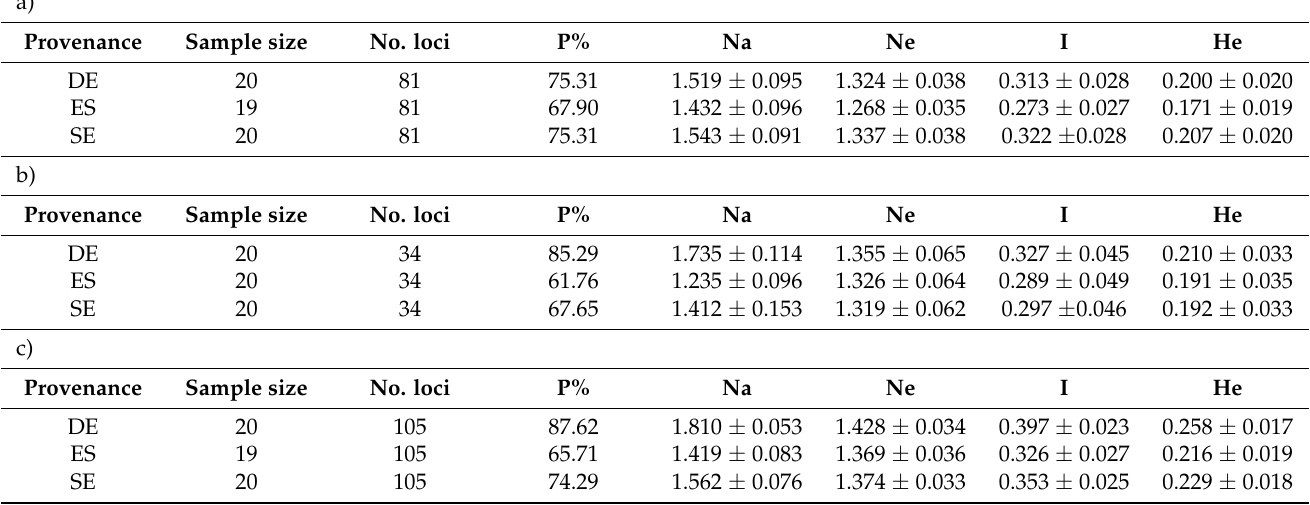
Table 3. Percentage of analyzed methylated restriction sites (mean values ± SD) in German (DE), Spanish (ES), and Swedish (SE) provenances. DE ES SE Full or hemi-methylated internal C 31.1% ± 2.9% 30.7% ± 2.4% 30.8% ± 2.5% Hemi-methylated external C 0.9% ± 1.0% 1.5% ± 0.7% 1.2% ± 1.1% Total 32.1% ± 2.7% 32.3% ± 2.7% 32.0% ± 2.7% Epigenetic diversity parameters, such as the average number of observed alleles (Na), number of effective alleles (Ne), Shannon’s diversity index (I) and expected heterozygosity (He), were lower in the ES than in the DE and SE provenances (Table 4a), with the DE and SE showing similar values for all of them (Table 4a). Table 4. Epigenetic (a) and genetic (b,c) diversity parameters estimated for individuals of three provenances of Fagus sylvatica, Germany (DE), Spain (ES) and Sweden (SE), using MSAP-MSP (a), MSAP-MIP (b) and AFLP (c) markers. No. loci = Number of loci, P% = Percentage of polymorphic fragments, I = Shannon’s diversity index, Na = Number of alleles, Ne = Number of effective alleles, He = Expected Heterozygosity, (mean values ±